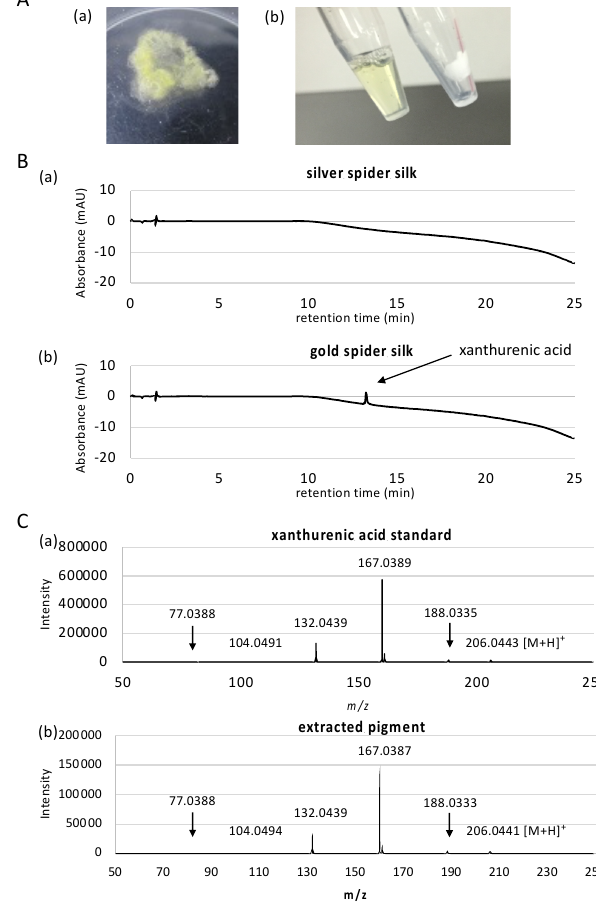
Figure 1. Extraction and measurement of pigment from dragline silk. ( A ). Dragline silk was collected from Trichonephila clavata ( a ) and ( b ) destained with 1% sodium dodecyl sulfate (SDS) solution (right tube; destained silk, left tube; extracted solution containing gold pigment). ( B ). LC chromatograms of silver spider silk ( a ) and ( b ) gold spider silk. A peak at 13.27 min corresponding to xan- thurenic acid was only observed in the gold dragline. ( C ). MS/MS spectrum of xanthurenic acid standard ( a ) and extracted pigment ( b ) peak specifically detected in gold sample. Both samples show identical